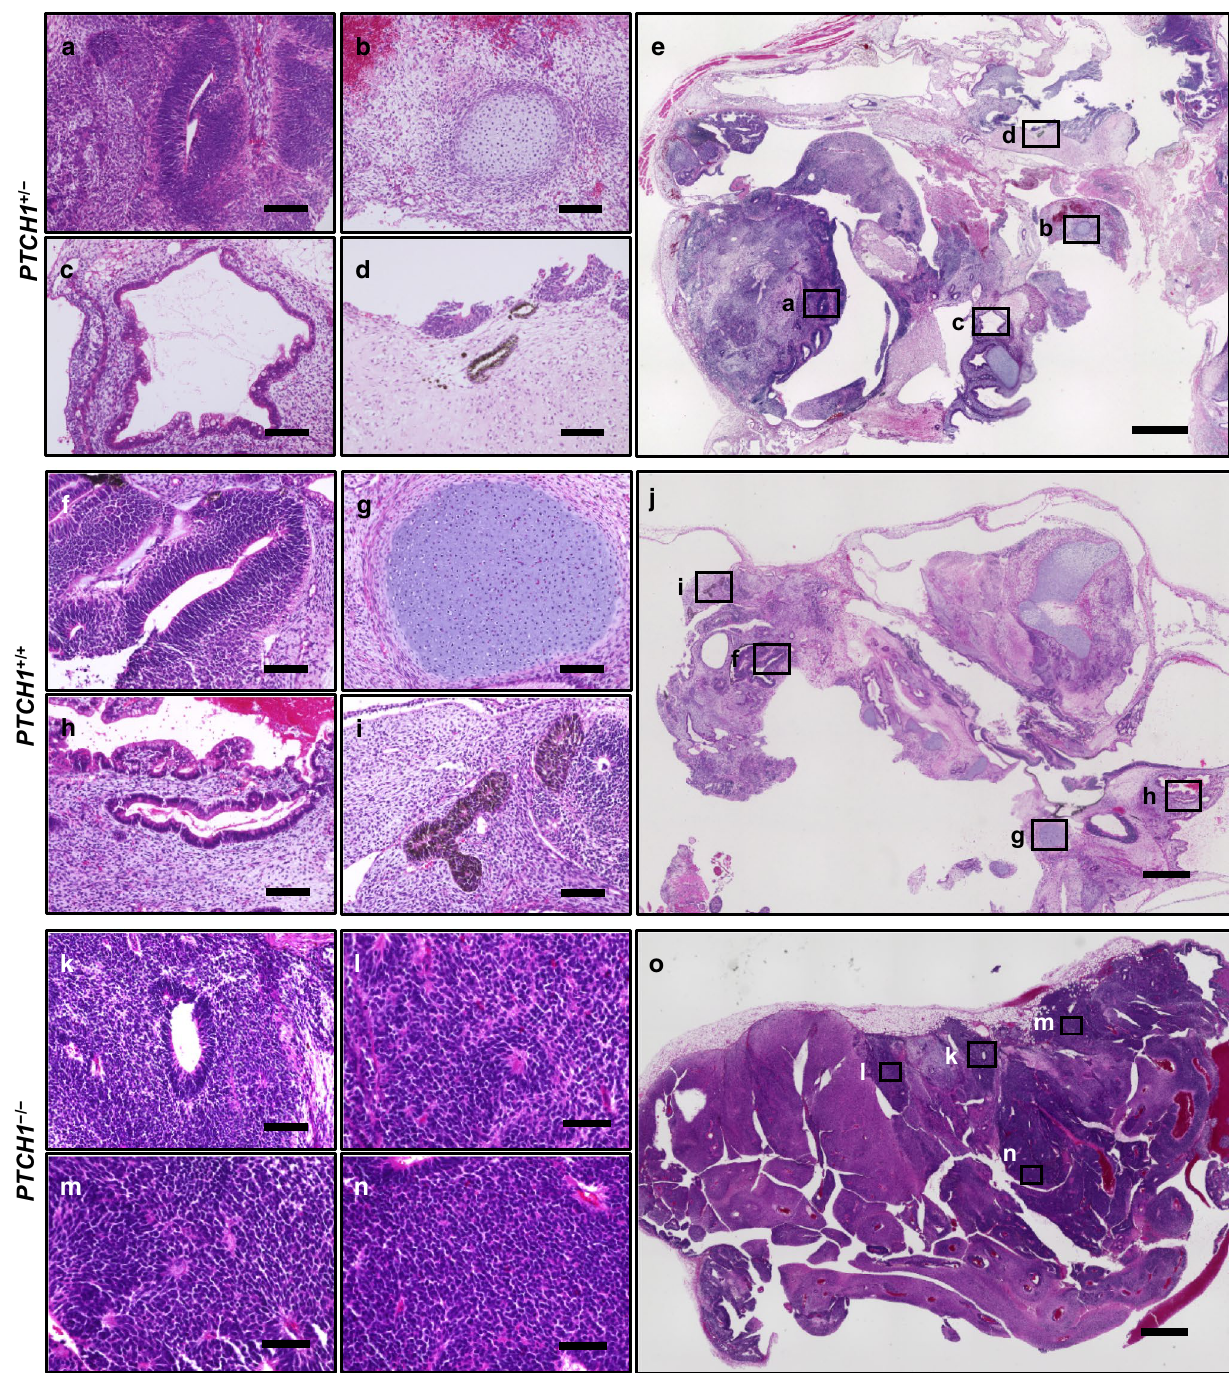
Fig. 3 HE staining of PTCH1 +/− , PTCH1 +/+ , and PTCH1 −/− teratomas. HE staining of a PTCH1 +/− teratoma (G11-NBCCS) (a-e), PTCH1 +/+ teratoma (G11 PTCH1 +/+ ) ( f – j ), and PTCH1 −/− teratoma (G36 PTCH1 −/− ) ( k – o ). Neural tubes ( a , f , k ), cartilage ( b , g ), the intestine ( c , h ), and melanocytes d , i are shown. Whole-slice images of teratomas are shown in e, j , and o . Higher magnifications of the areas indicated by rectangles in e , j , and o are shown in a-d, f-i, and k-n. Scale bars: 100 μm in a – d , f – i , and k , 1 mm in e , j , and o , 60 μm in l –